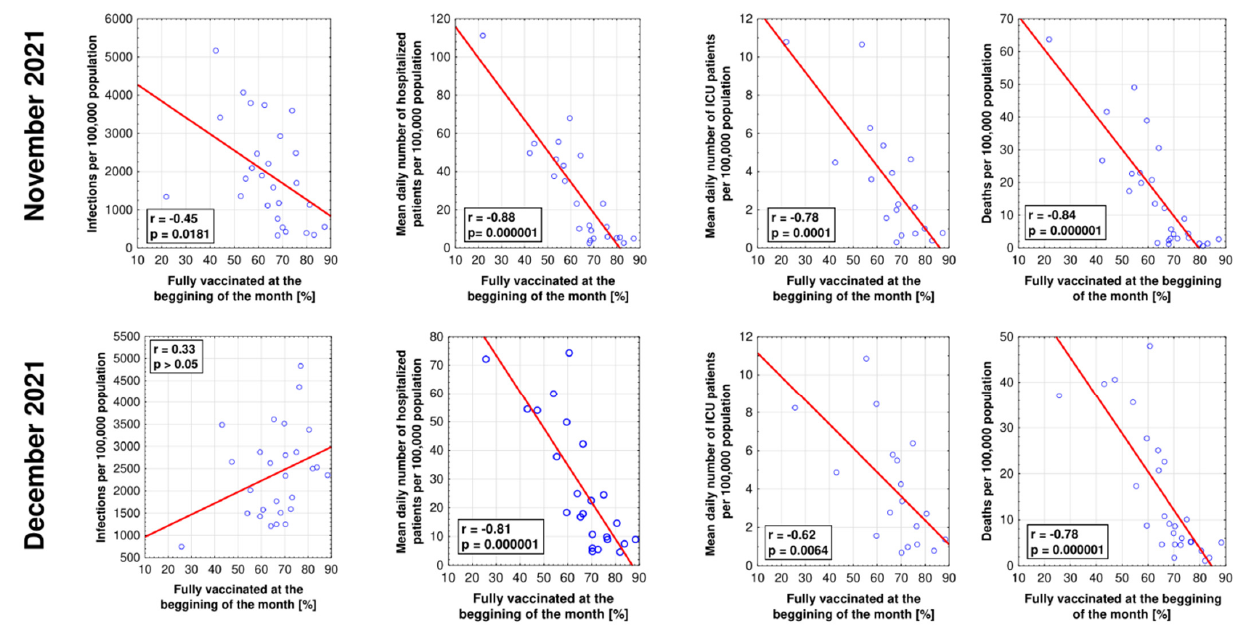
Figure 2. The correlations between the share of fully vaccinated individuals and the infection rate, mean daily hospitalizations and ICU admissions, and death rate in the autumn 2021 SARS-CoV-2 wave in EEA countries.